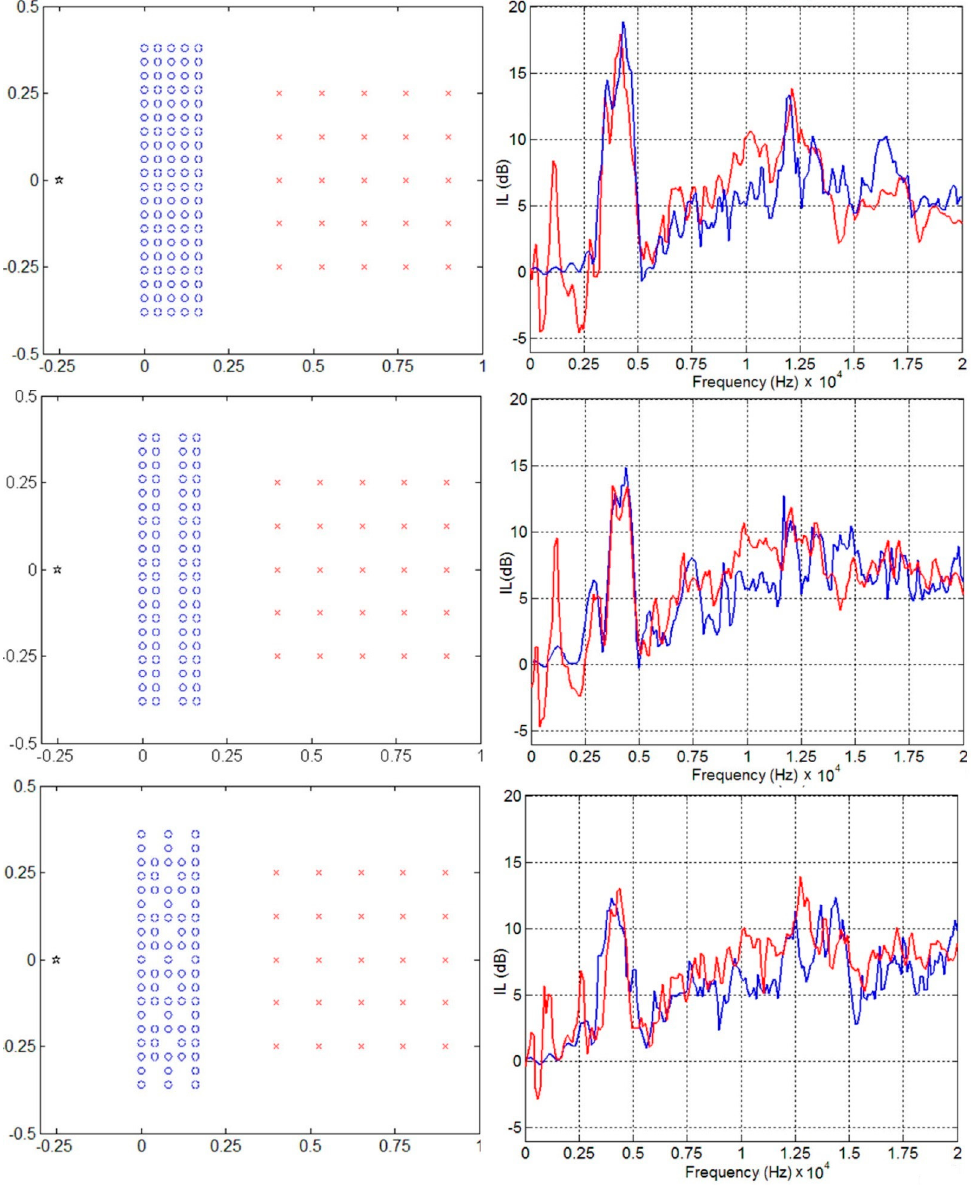
Figure 6. Rows of scatterers or random scatterers repositioned from rectangular lattice, modified from [51].